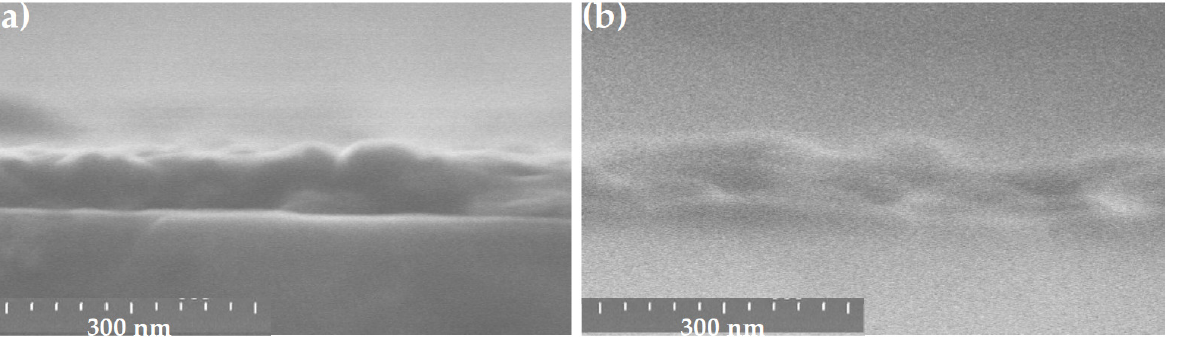
Figure 11. Cross-sectional SEM views of sol-gel spin-coated ZnO films deposited on c-Si ( a ) and glass substrate ( b ).